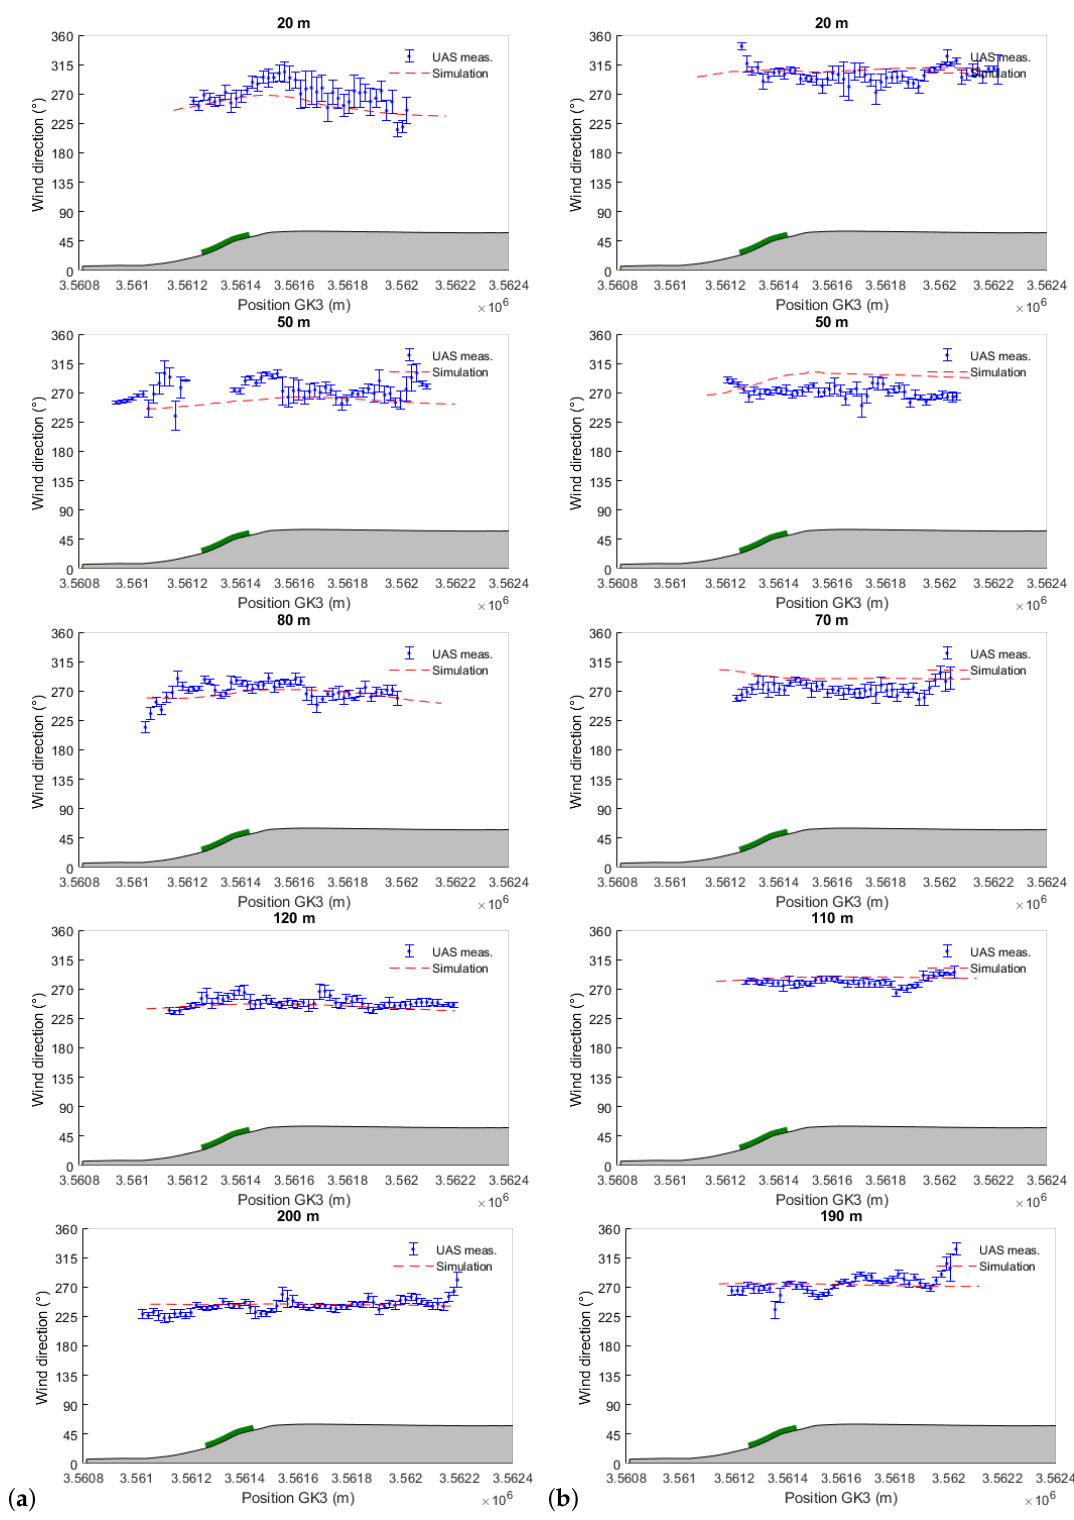
Figure 9. Wind direction on 21 ( a ) and 22 ( b ) September at different altitudes along the UAS’ flight path. See also Figure